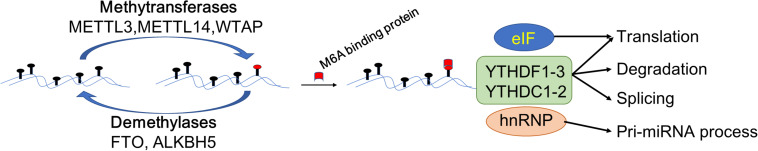
Schematic elucidation of m6A modification in the regulation of gene expression. The m6A modification is catalyzed by methyltransferases METTL3/14, Wilms tumor 1-associating protein (WTAP). The demethylases fat mass and obesity-associated protein (FTO) and AlkB homolog 5 (FTO/ALKBH5) demethylated the bases modified by m6A. Methylated reader proteins recognize the mRNA modified by m6A, thereby activating downstream pathways by different reader proteins. After modified by methyltransferases, eIF3 proteins promote mRNA translation. HNRNPA2B1 regulates the processing of the pre-miRNA and pri-miRNA. Further, YTHDF1-3, YTHDC1-2 can regulate the processes of RNA translation, degradation, and splicing.